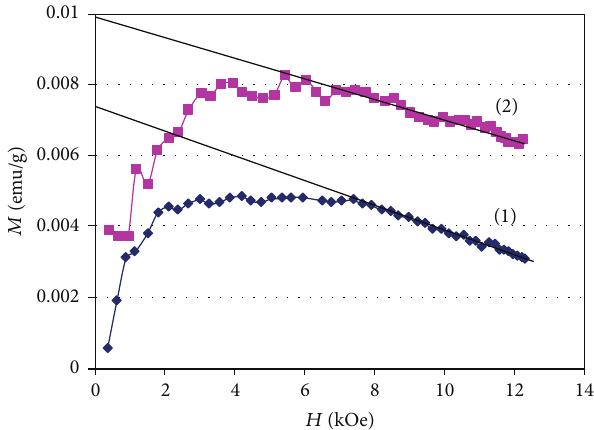
Figure 5: Room temperature 𝑀 - 𝐻 curves for ZnO-Zn NP: (1) as prepared and (2) after annealing.